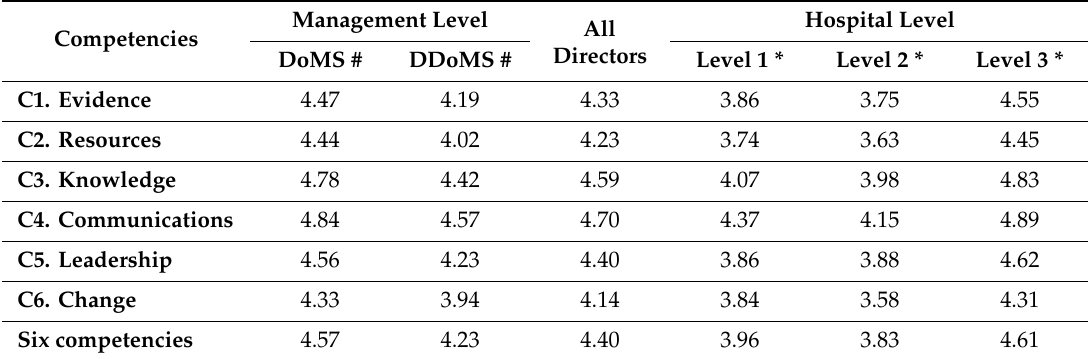
Table 6. Mean scores of self-assessed management competencies by management level and hospital. Competencies